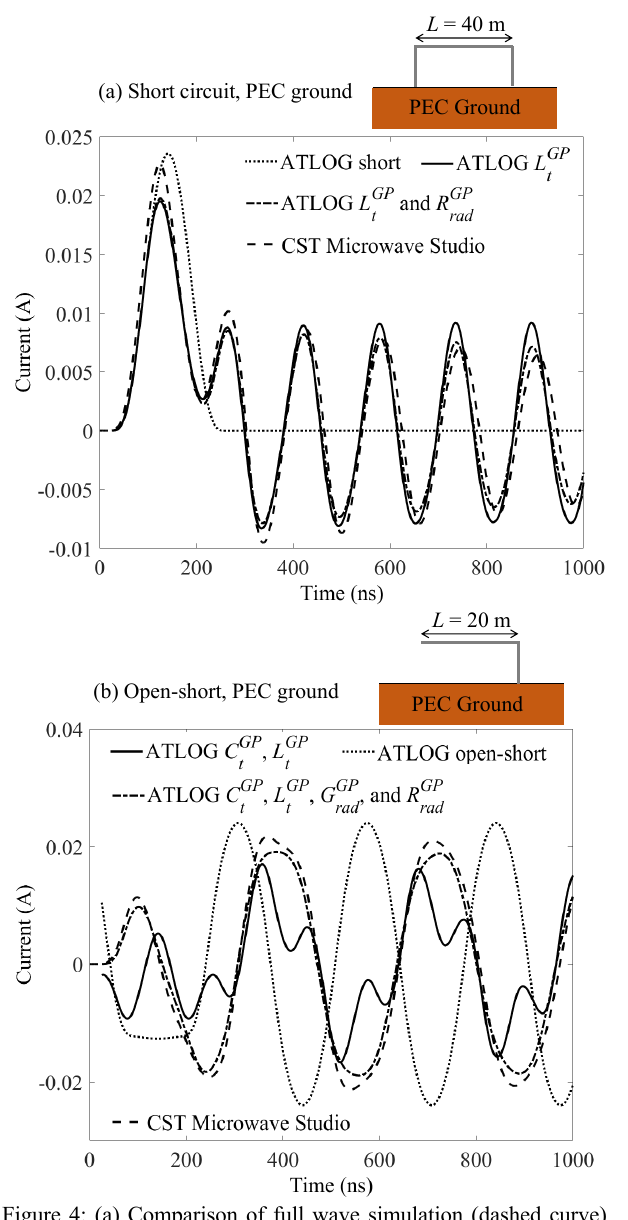
Figure 4: (a) Comparison of full wave simulation (dashed curve) using CST Microwave Studio with the ATLOG transmission line calculations for a 40 m long section of line over perfectly conducting ground having short circuits at both ends. The dotted curve has idealized short circuits at each end (and has no ringing at normal incidence), the solid curve has terminating inductors at each end and shows ringing, and the dash-dot curve has terminating inductors and radiation resistances at each end. (b) Comparison of full wave simulation (dashed curve) using CST Microwave Studio with the ATLOG transmission line calculations for a 20 m long section of line over perfectly conducting ground having an open circuit at the left end and a short circuit at the right end. The dotted curve has idealized open and short circuits at the two ends, the solid curve has a terminating capacitor and inductor at the respective ends, and the dash-dot curve has terminating capacitor-radiation conductance and inductor-radiation resistance at the respective